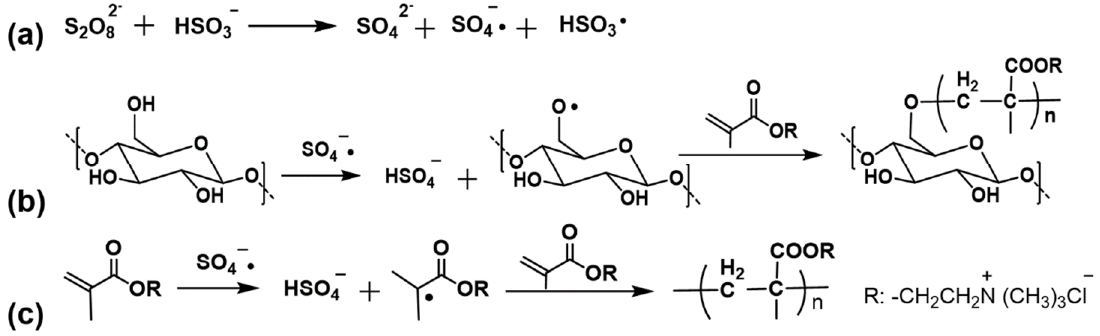
Figure 1. ( a ) Formation of free radicals; ( b ) reaction mechanism of grafting DMC onto cotton fiber in the presence of K 2 S 2 O 8 / NaHSO 3 ; ( c ) homopolymerization of DMC.